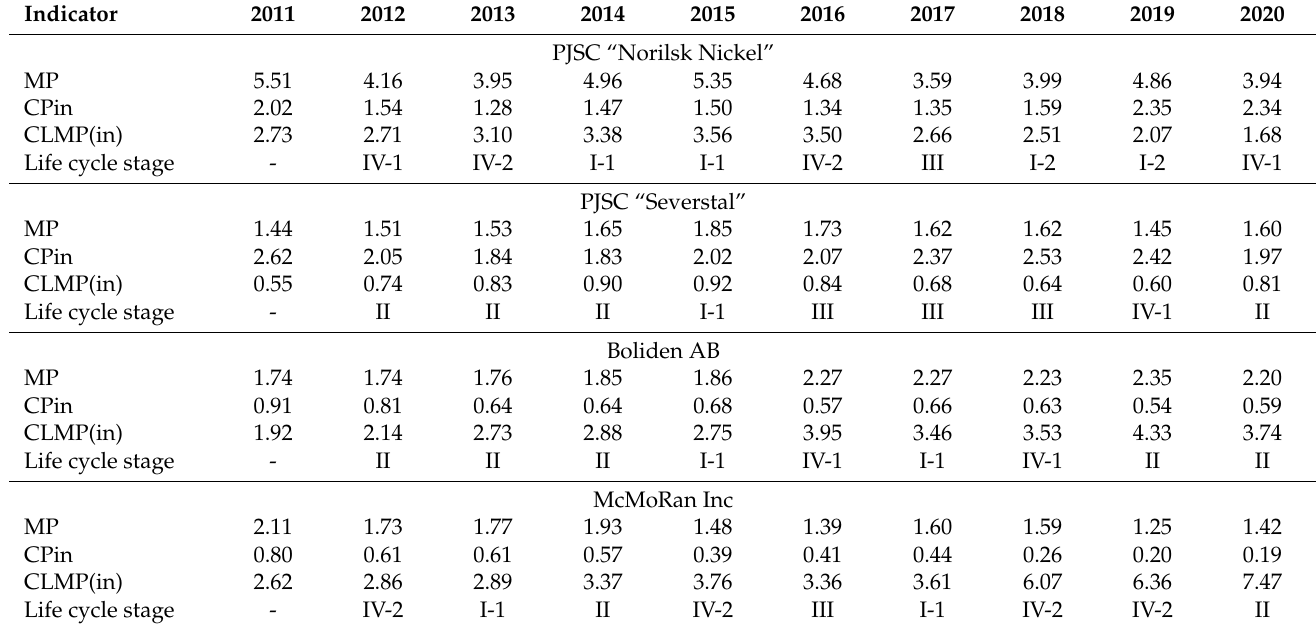
Table 2. Dynamics of the three sustainability indicators for the technological development of large energy-intensive